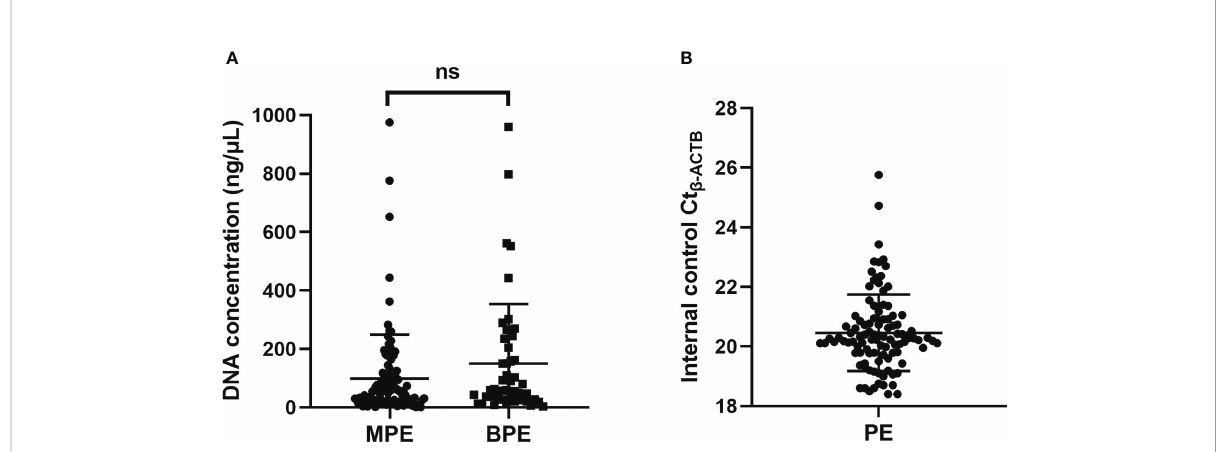
FIGURE 1 (A) The concentration distribution of pleural effusion between MPE and BPE. (B) The distribution of the Ct value of the internal control b-ACTB. ns, not signi fi cant; MPE, malignant pleural effusion; BPE, benign pleural effusion; PE, pleural